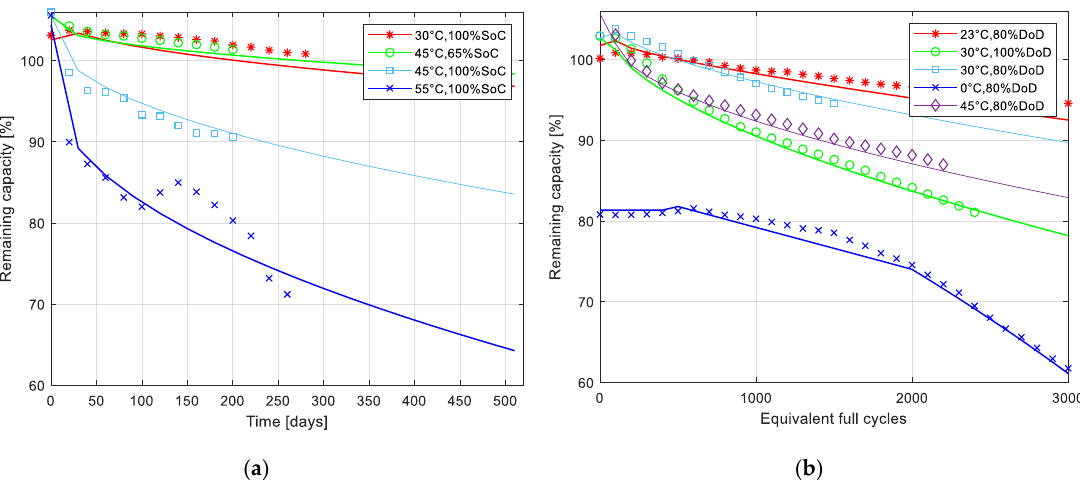
Figure 7. Simulated (line) and measured (marker) remaining capacity for semi-empirical model ( a ) calendar aging at (100%, 65% SoCs) and several temperatures; ( b ) cycle aging at various DoDs and temperatures at 1 charging rate. The experimental data is from [63] . Table 3. Maximum root mean square error [%] for both empirical and semi-empirical models. Degradation type